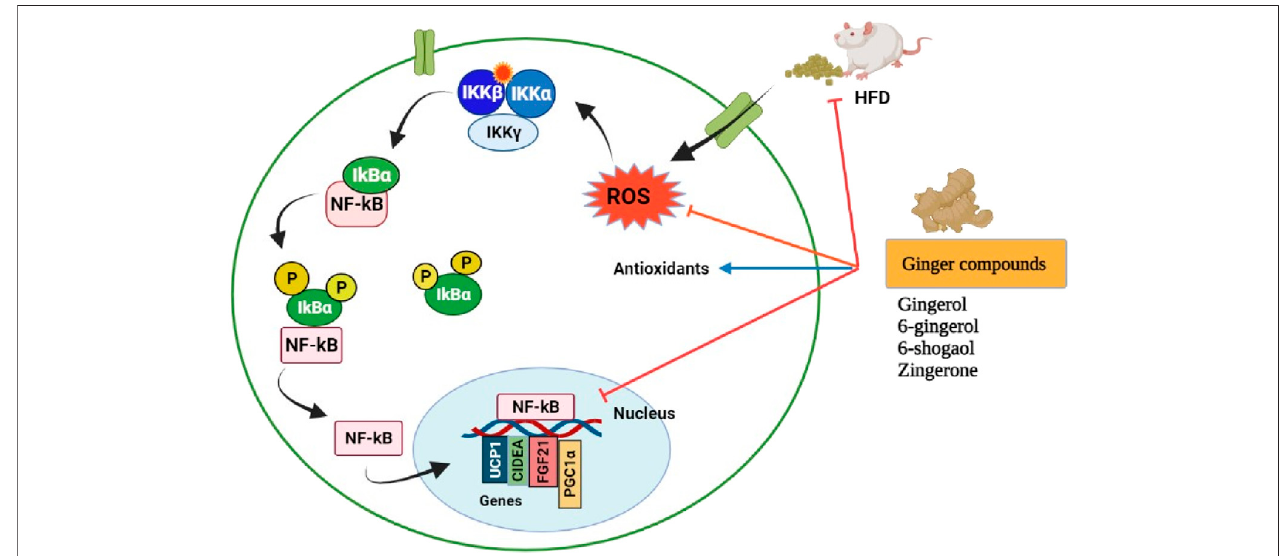
FIGURE8| Pharmacological actionsofgingerphytoconstituentsonobesity.NF-kB, nuclearfactorkappaB;IKK( βα γ );IkappaBkinasecomplex;IkB α ,Ikappa-B- alpha; UCP1, uncoupling protein 1; CIDEA, Cell death-inducing DFFA like effector A; FGF21, Fibroblast growth factor 21; PGC-1 α , Peroxisome proliferator-activated receptor gamma coactivator; ROS, Reactive oxygen species; P, Phosphorylation; HDF, High fat diet. Figure was created using BioRender.com by the authors.